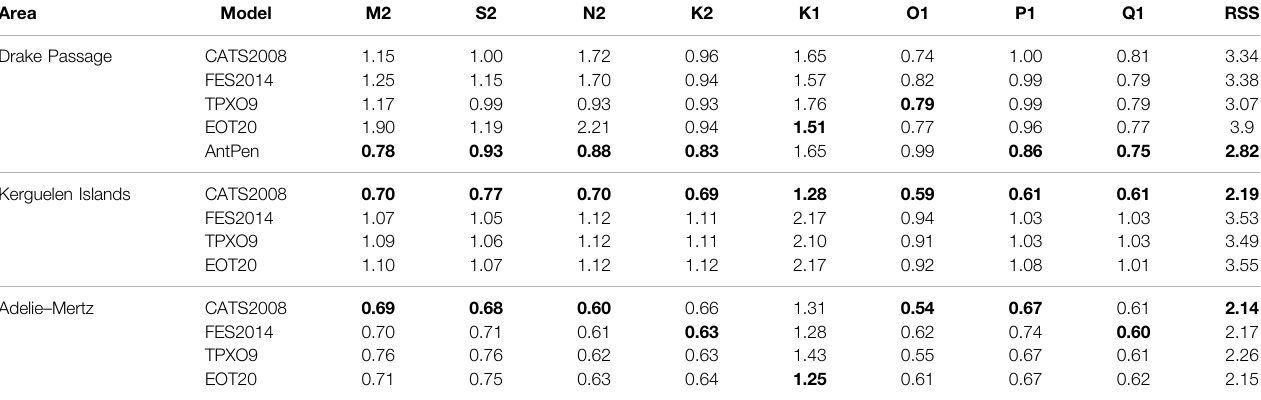
TABLE 3 | Comparison between fi ve tide models and tidal records for eight main constituents in the Drake Passage, Kerguelen Islands, and Adelie – Mertz. Bold values denote the smallest RMS and RSS values. (Unit: cm). Area